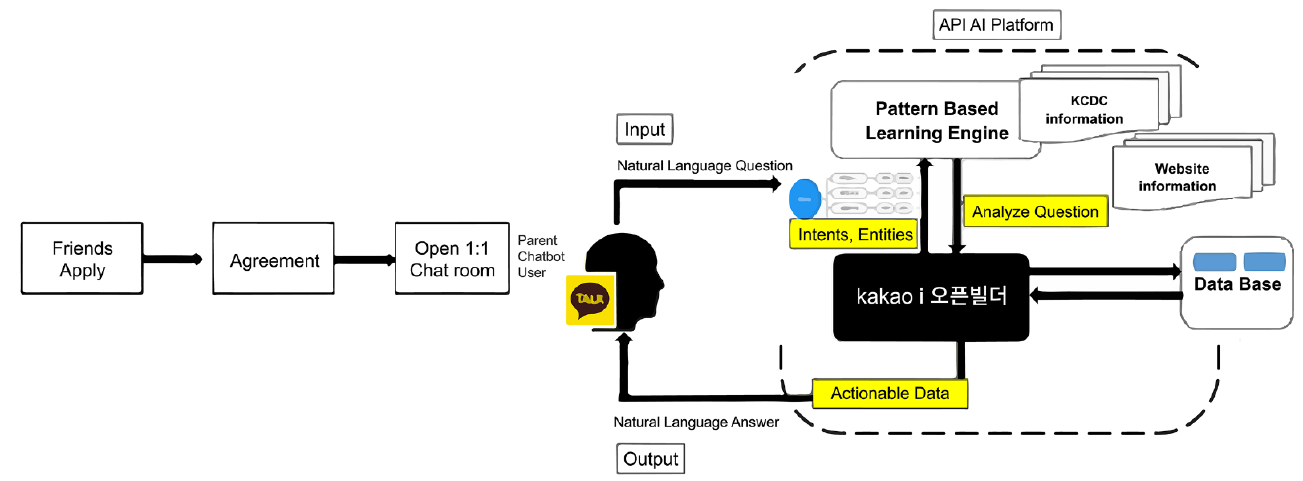
Figure 5. The dialogue architecture of the child vaccination chatbot. Table 2. Child vaccination chatbot’s service scenario.